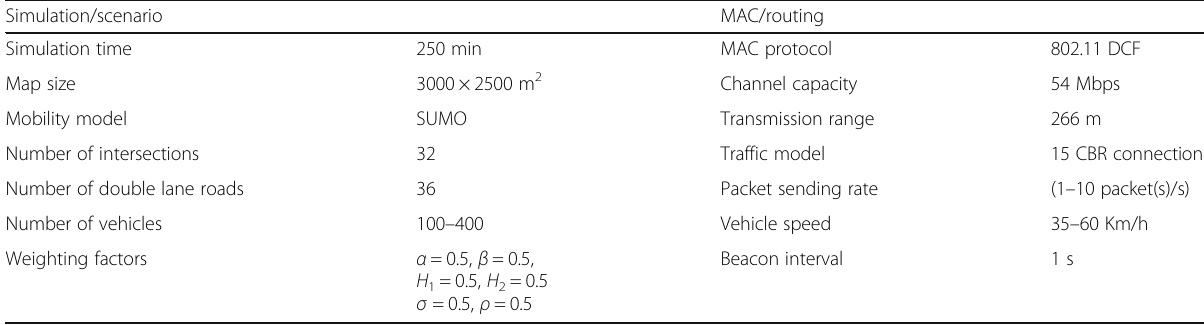
Table 2 Simulation